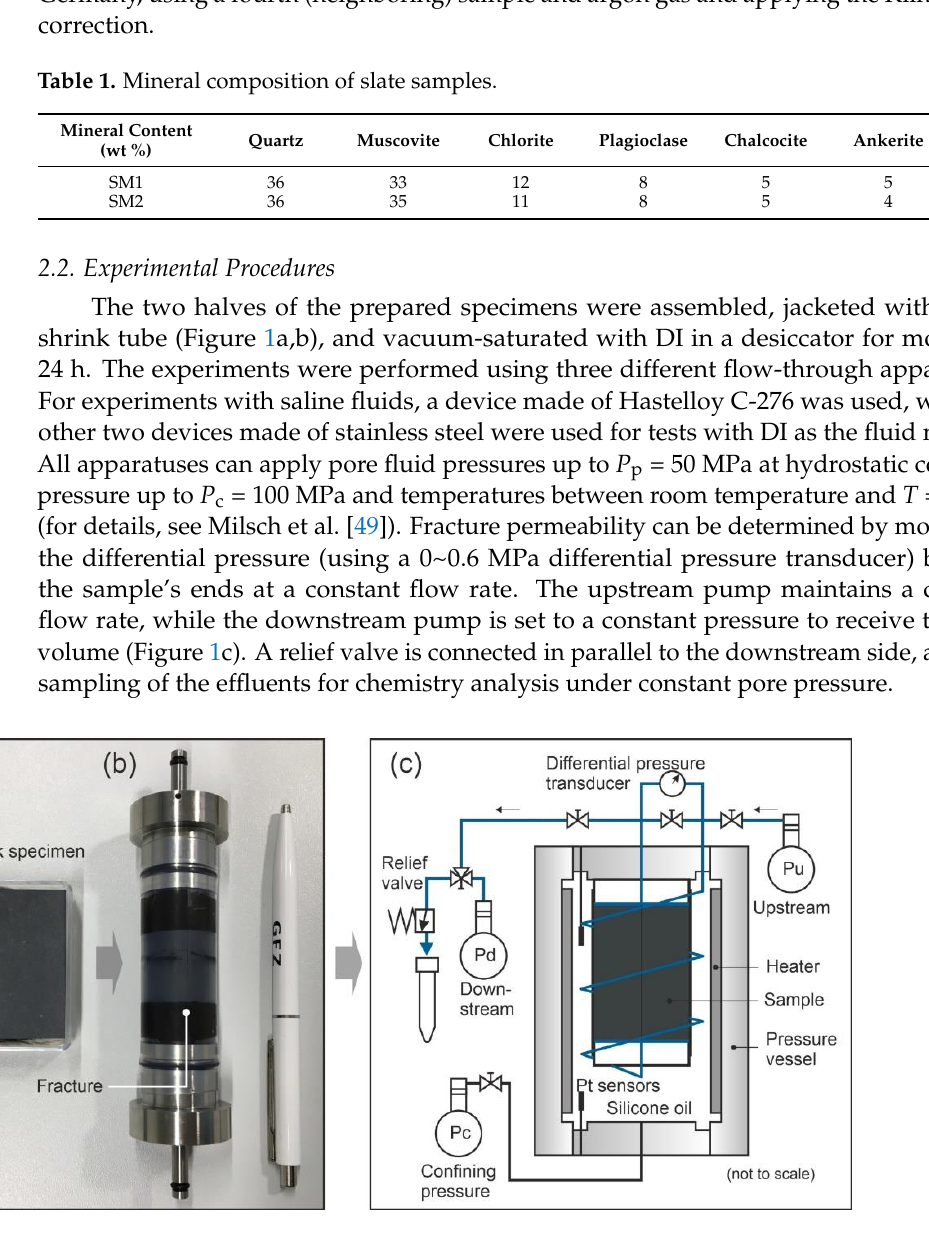
Figure 1. Workflow for the long-term flow-through experiments, ( a ) two halves of prepared slate specimens, ( b ) the assembled sample jacketed with heat-shrink tubing, and ( c ) the flow-through apparatus.